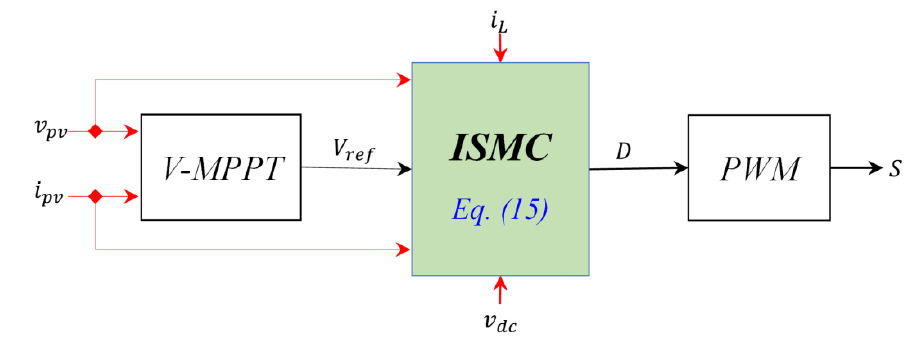
Figure 6. Block diagram of proposed VO-MPPT.